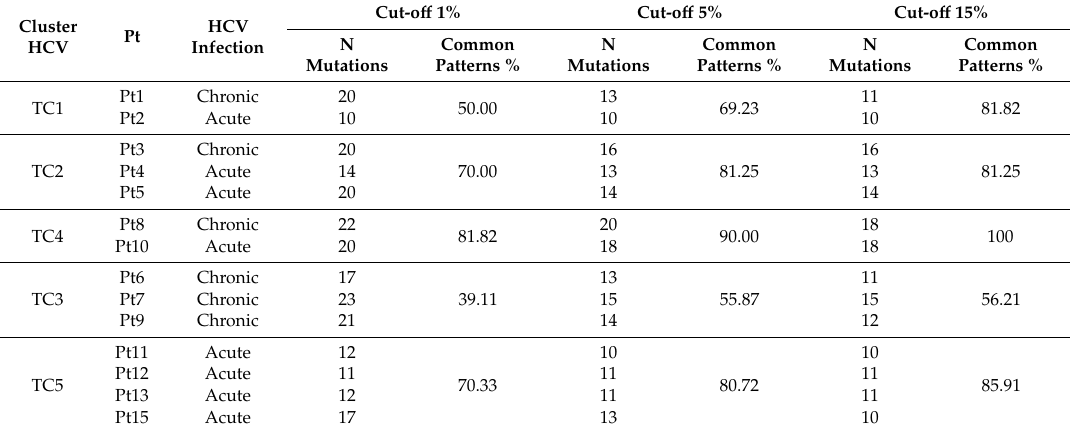
Table 3. Common patterns transmitted within the same clusters according to di ff erent cuto ff